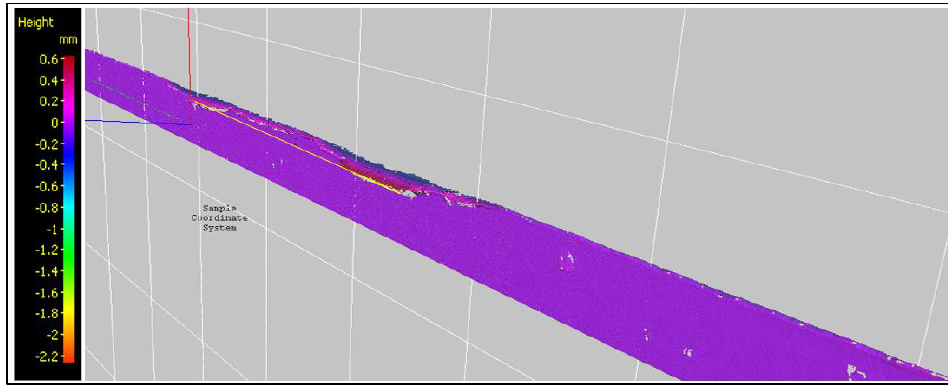
Figure 8 . Wear on the cutting edge of knife No. 1 . Figure 8. Wear on the cutting edge of knife No.